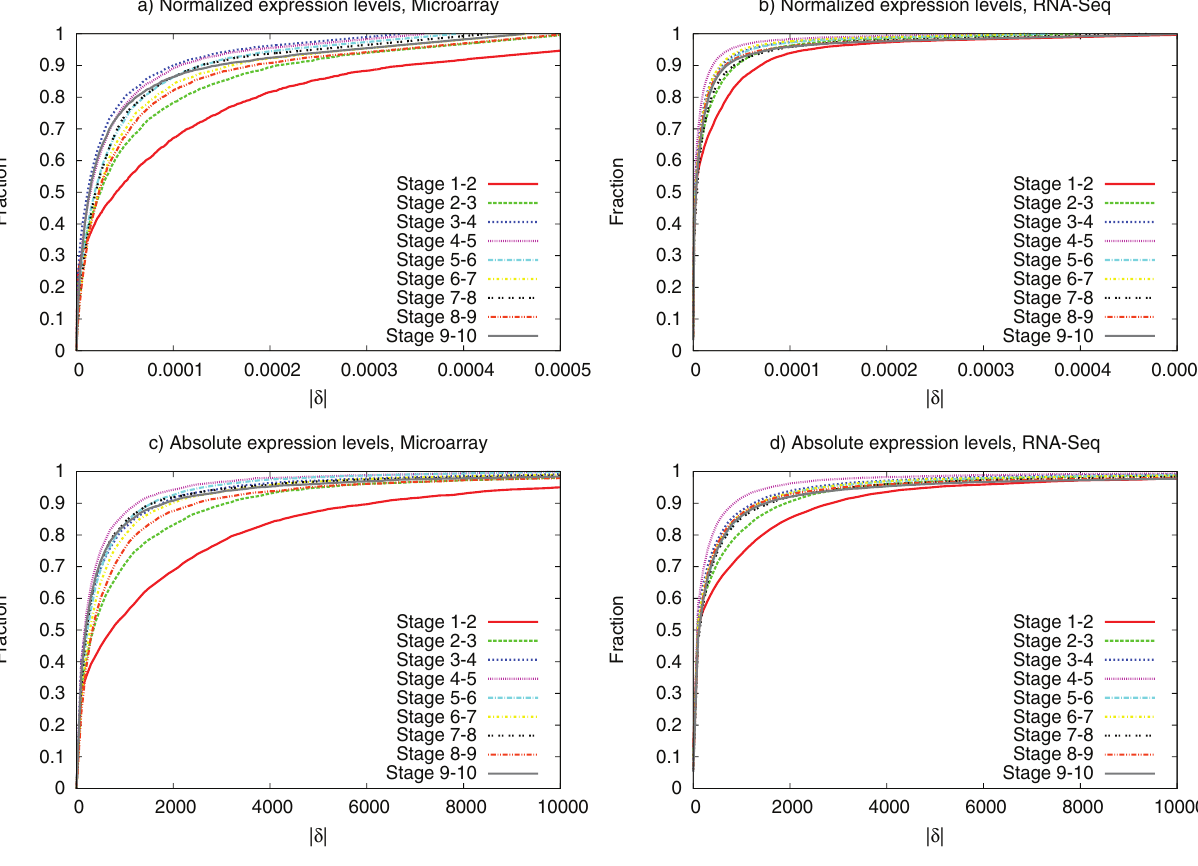
Figure S3. Drosophila data: CDFs of the expression level absolute variations | δ | across successive stage-pairs. ( a ) normalized expressions, Microarray, ( b ) normalized expressions, RNA-Seq, ( c ) absolute expressions, Microarray, absolute expressions, RNA-Seq. [Dataset